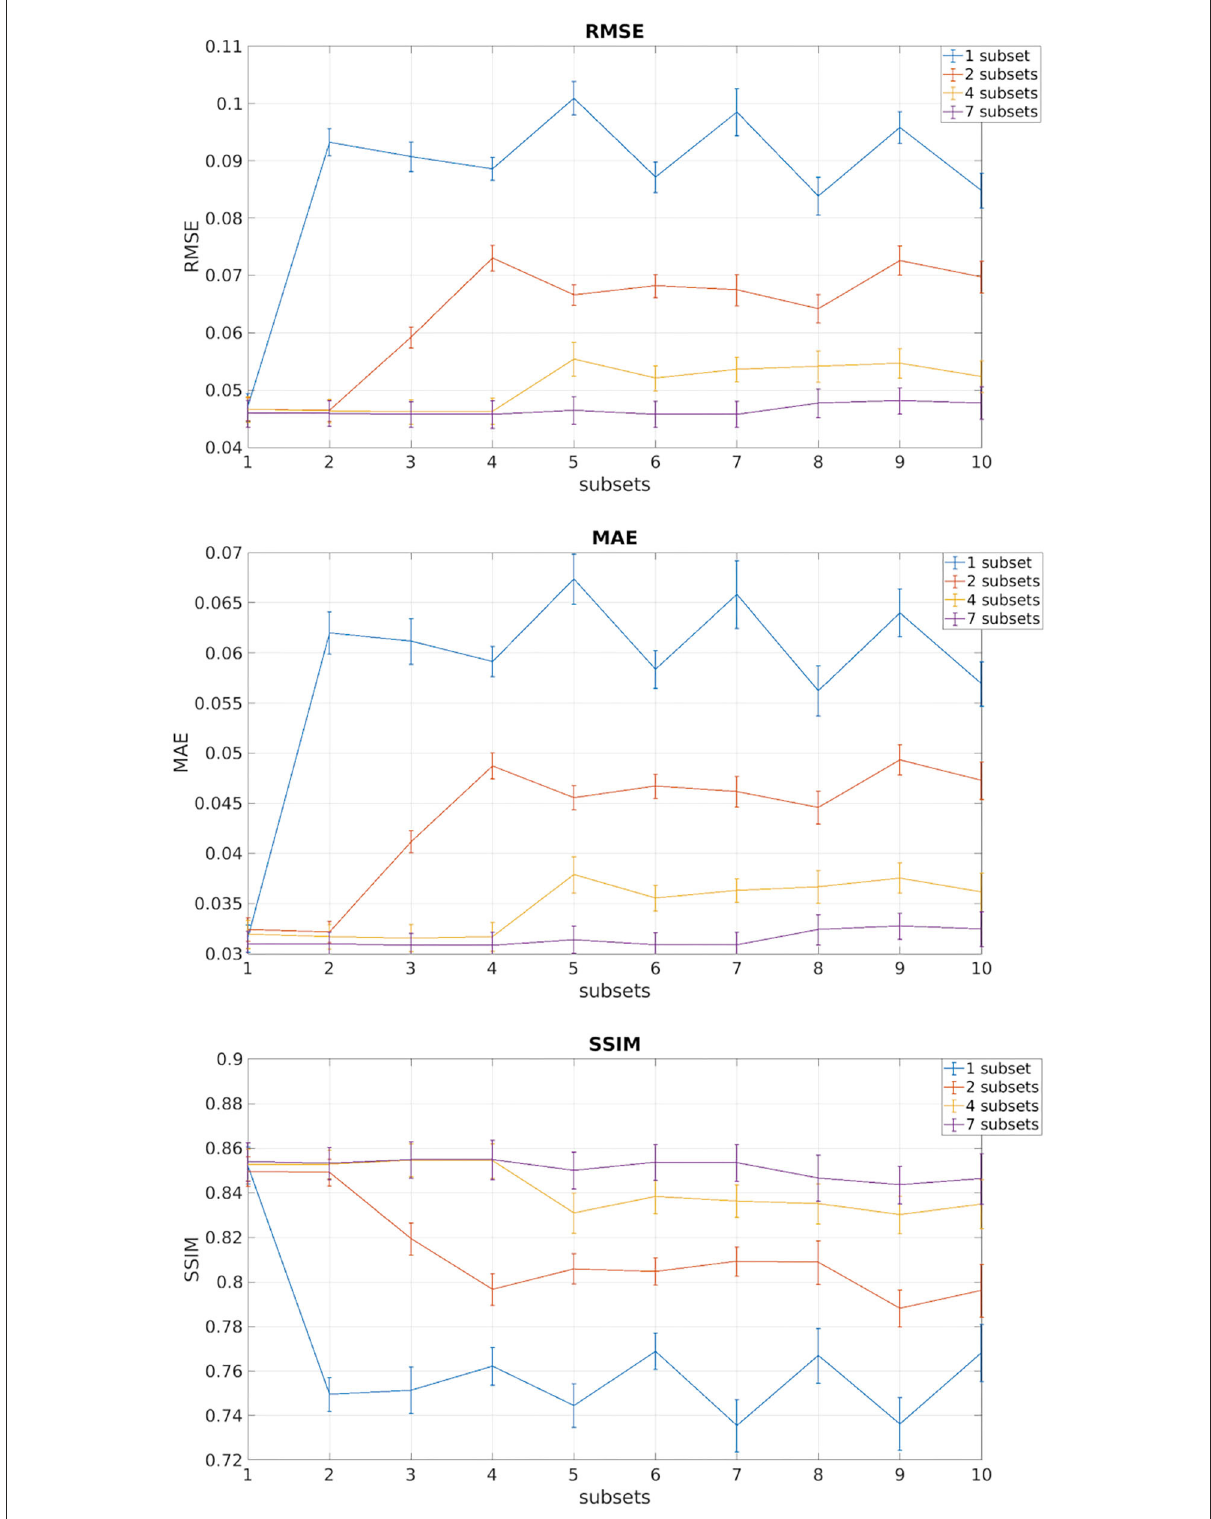
FIGURE3 In each of the plots are reported the mean and standard deviation of the three metrics root mean square error (RMSE), mean absolute error (MAE), and structural similarity index measure (SSIM) of the test subjects for each of the 10 DW subsets. Each different color indicates the number of DW subsets (1, 2, 4, 7) used for training the